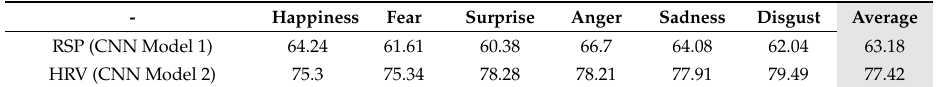
Table 5. Accuracy of single-signal for six emotions classification.